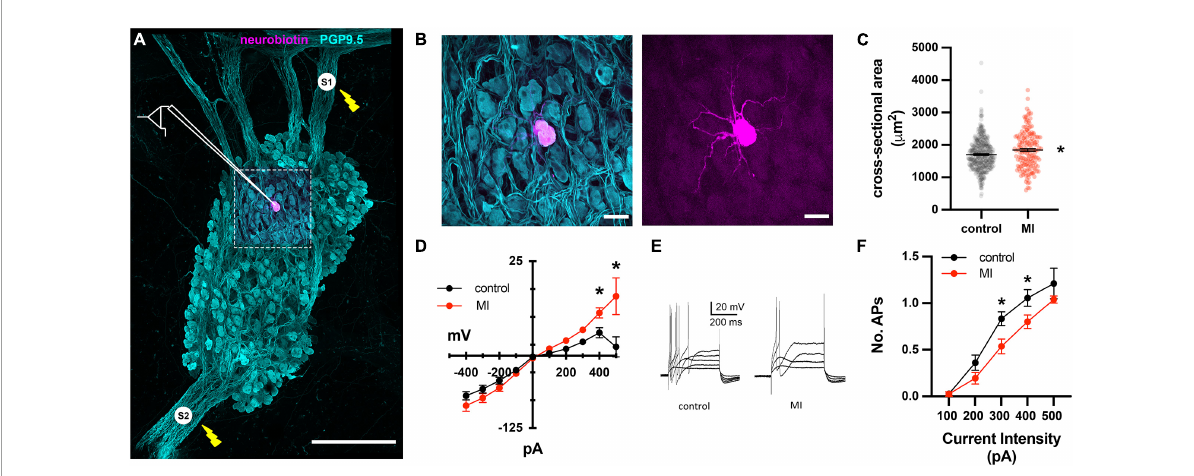
FIGURE3 Depressed excitability of ICNs from MI animals shown by intracellular assessment of ICN membrane physiology. (A) Schematic overlay of the stimulation and recording configuration over a stitched confocal image (40 × ) of an individual intrinsic cardiac ganglion. Bipolar stimulating electrodes ( labeled S1 and S2 ) were placed on interganglionic nerves. The magenta cell was backfilled with neurobiotin from the recording electrode. Scale bar is 500 µ m. (B) Split images of boxed region in (A) , showing all cells ( left ) and single labeled cell ( right ). Scale bar 50 µ m for both panels. (C) The cross-sectional areas of ICNs from pigs with MI were larger than controls. * Indicates P < 0.05, Fisher’s exact test. (D) The steady state membrane voltage in response to intracellularly injected current is plotted for MI and control ICNs. Input resistances were similar between groups but MI cells tended to have greater depolarizations in response to 400 and 500 pA currents. * Indicates P < 0.05, Šidák’s multiple comparisons test. (E) Membrane potential responses to long duration (500 ms), intracellular depolarizing current pulses from a control and MI neuron. Note that ICNs from control animals typically fired multiple action potentials in response to depolarization, while MI ICNs only fired a single action potential. (F) The reduced excitability of MI neurons is evident from the decreased slope of the excitability curve, plotting the number of evoked action potentials vs. the range of depolarizing current pulse amplitudes. * Indicates P < 0 . 05, Šidák’s multiple comparisons test.